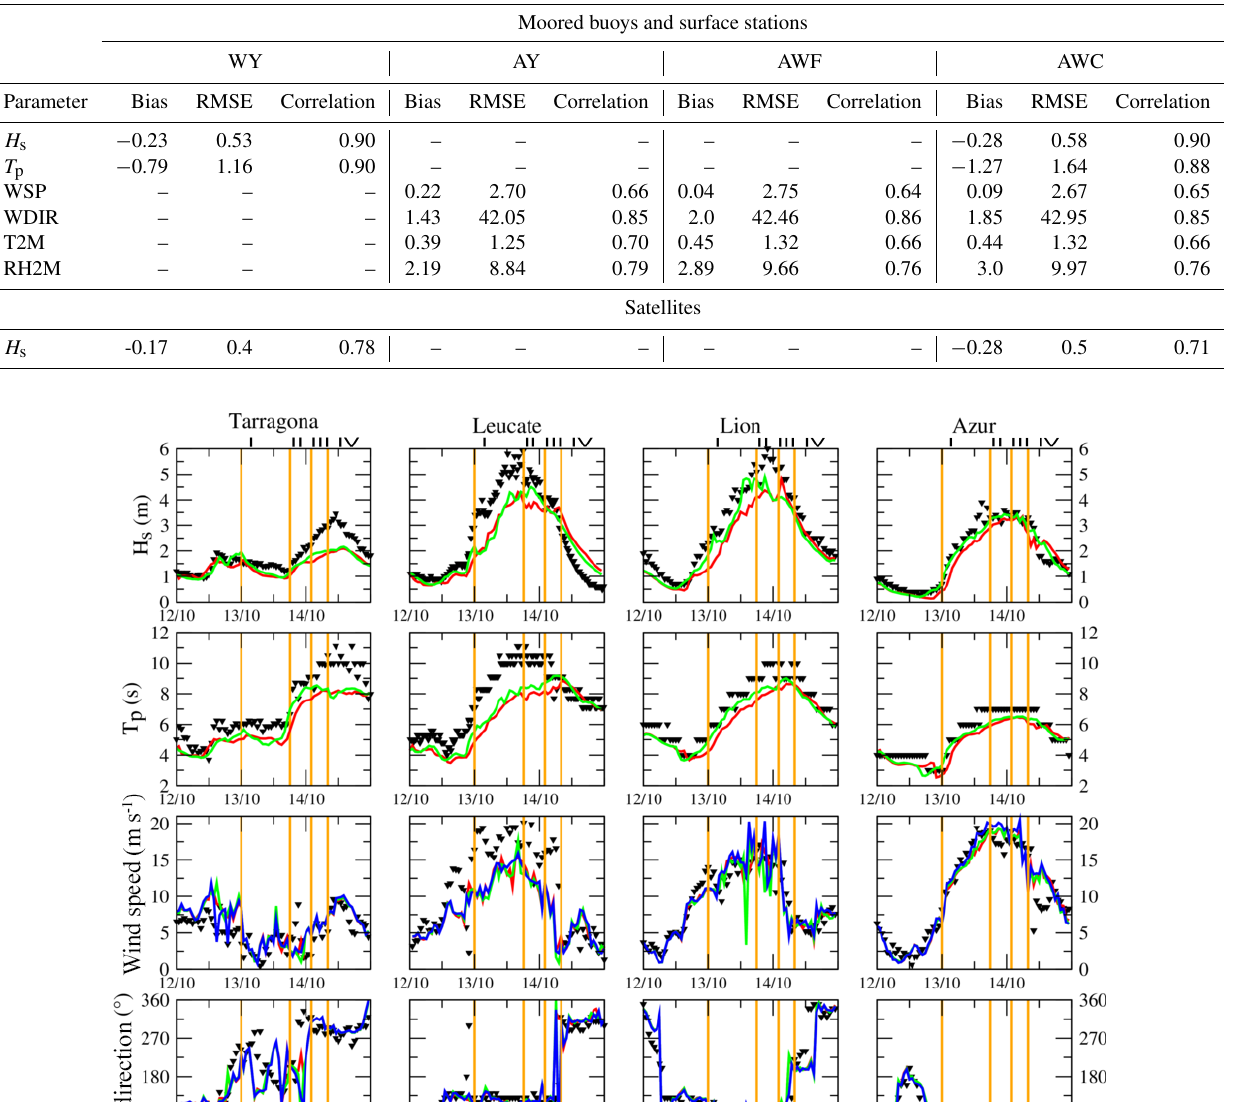
Table 2. Skill scores computed against surface stations and satellite data for the wave-only simulation (WY) and the coupled simulation (AWC) for wave parameters ( H s , T p ) and for the atmosphere-only simulations (AY and AWF) and coupled simulations (AWC) for atmo- spheric parameters. WSP represents 10m wind speed (ms − 1 ), WDIR represents 10m wind direction ( ◦ ), T2m represents 2m air temperature ( ◦ C) and RH2M represents 2m relative humidity (%).